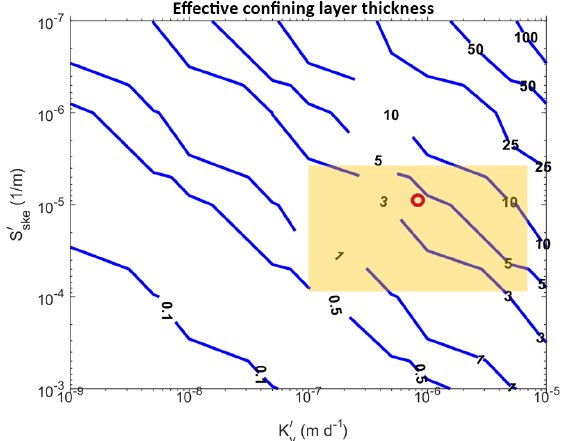
Figure 5. Plot of aquitard thicknesses responsible for contributing to elastic compaction associated with seasonal head changes for a range of elastic skeletal specific storage values and hydraulic con- ductivity values of the confining units. The orange box represents the range of parameter values found in the literature for extensome- ter sites in the United States. The red circle represents the optimal values from the numerical analysis of Pavelko